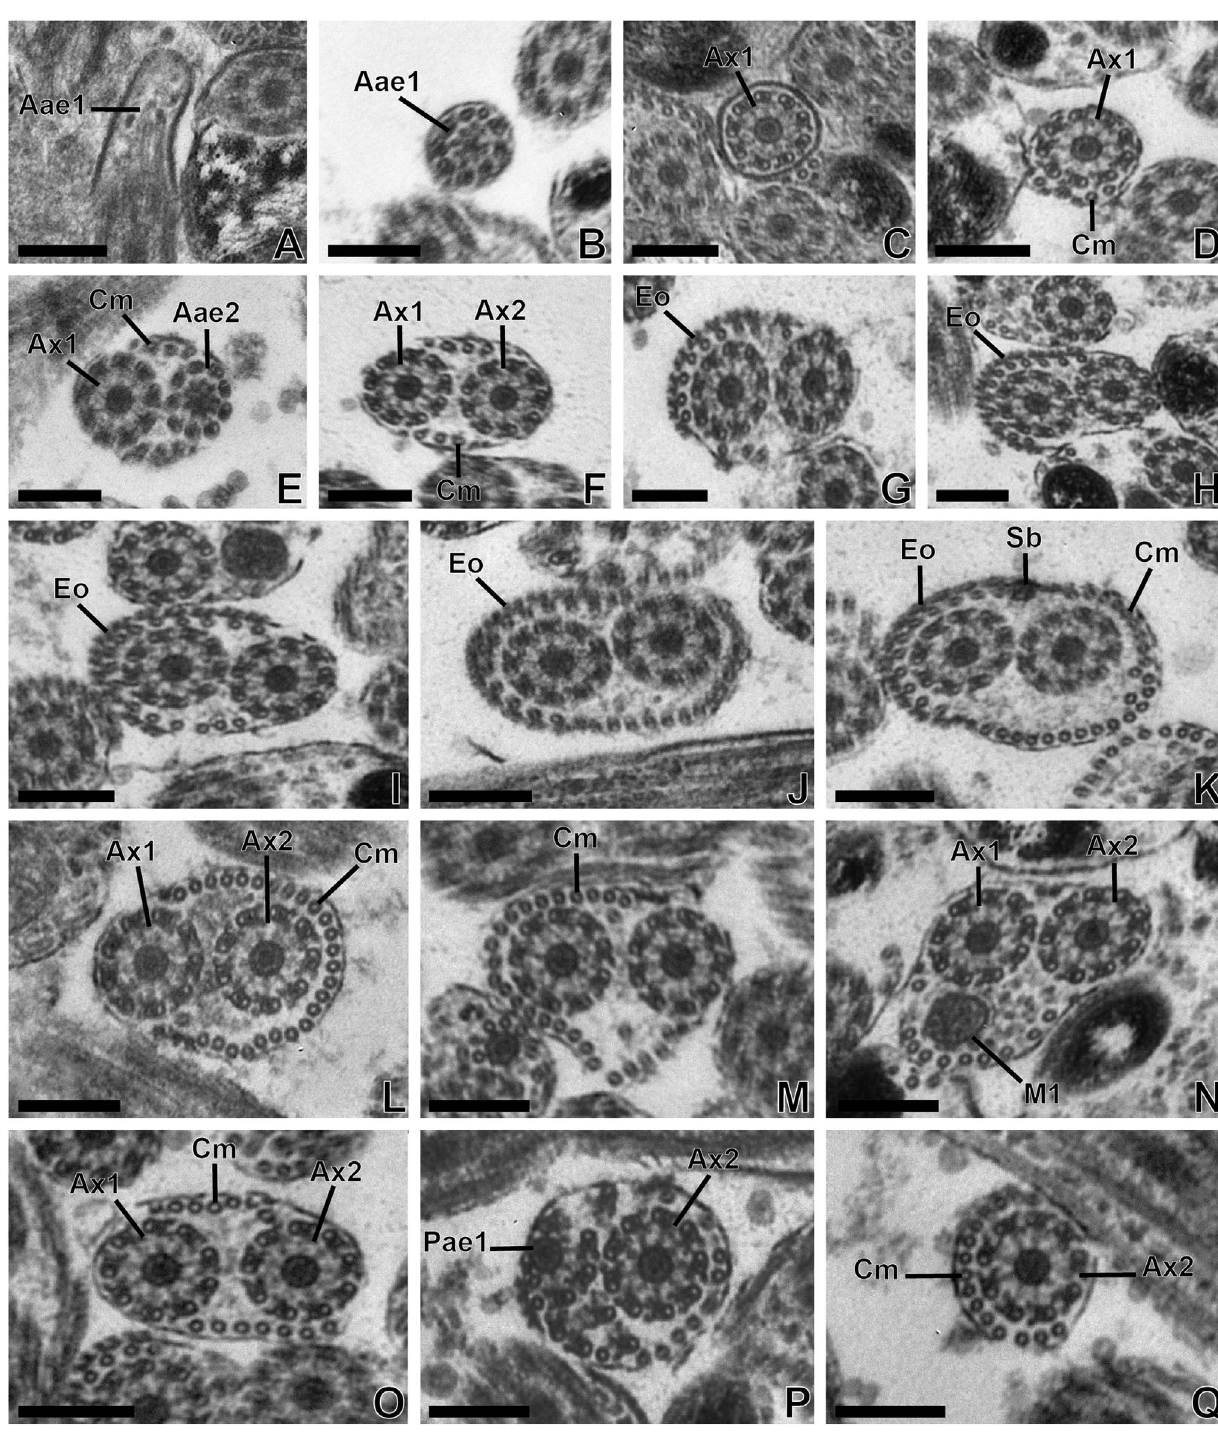
Figure 3. (A – Q) Transmission electron micrographs of regions I, II and III of the mature spermatozoon of Tergestia laticollis. Scale bars = 0.2 l m. (A – F) Sections in the anterior extremity of the spermatozoon. (A – B). Longitudinal (A) and cross-sections (B) in the anterior extremity of the spermatozoon with only the centriole of axoneme 1 (Aae1). (C) Cross-section in the anterior extremity of the spermatozoon with only one axoneme (A (cid:1) 1). (D) Cross-section in the anterior extremity of the spermatozoon with axoneme 1 and three cortical microtubules. (E – F) Cross- section in region I of the spermatozoon with axoneme 1 and the centriole of axoneme 2 (Aae2) (E), then the two axonemes (A (cid:1) 1 and A (cid:1) 2) (F). (G – K) Cross-sections in region II of the mature spermatozoon showing the two axonemes, an increasing number of cortical microtubules up to 36 in (K), and the external ornamentation of the plasma membrane (Eo) and spine-like body (Sb) (K). (L – Q) Cross-sections in region III of the mature spermatozoon showing only two axonemes and a row of 26 cortical microtubules (L), 25 (M), the appearance of the fi rst mitochondrion (M1) (N). Then, the disappearance of the fi rst mitochondrion (O), disappearance of axoneme 1 (Pae1) and the disorganization of axoneme 1 (P). (Q) Cross-section in the extremity of region III showing only a row of 13 cortical microtubules and axoneme